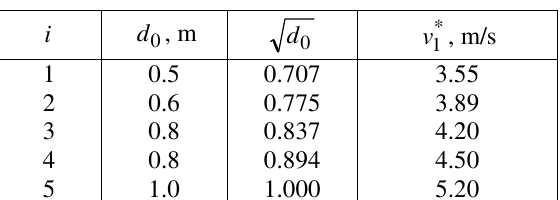
Table 2. Variation of speed with occupant position dis-